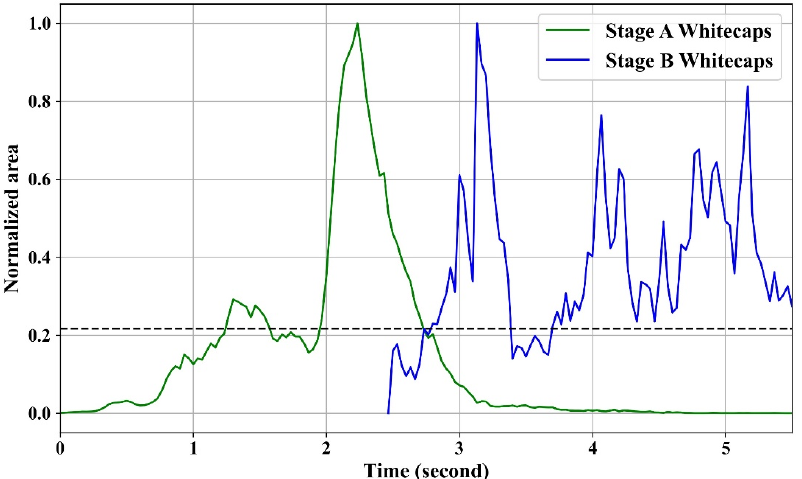
Figure 4. Time series of infrared signal of a breaking event. Stage A whitecaps are determined by bright area, and stage B whitecaps are determined by dark areas. The whitecaps areas are normalized by their respective maximums. The dashed line denotes the normalized area when the area of stage A was less than stage